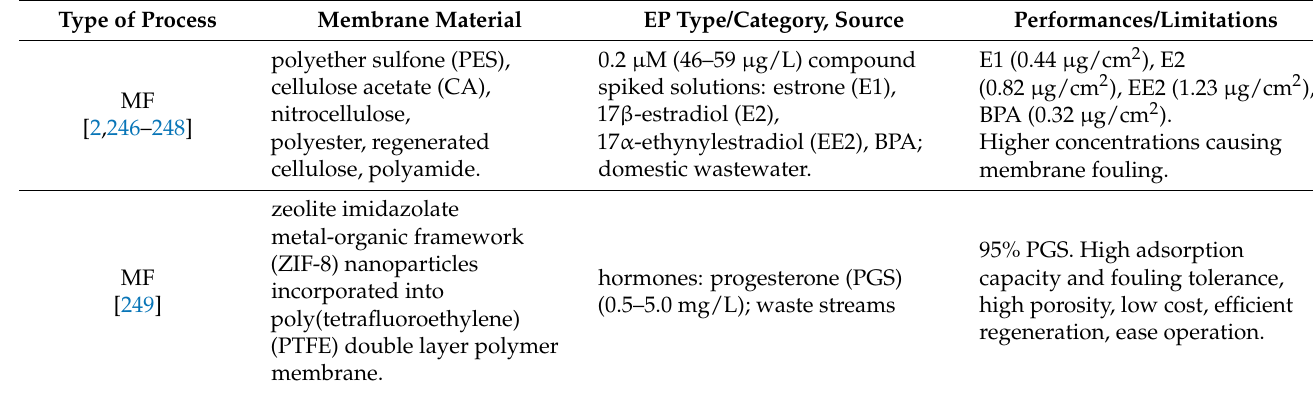
Table 3. Membrane materials used in EP separation